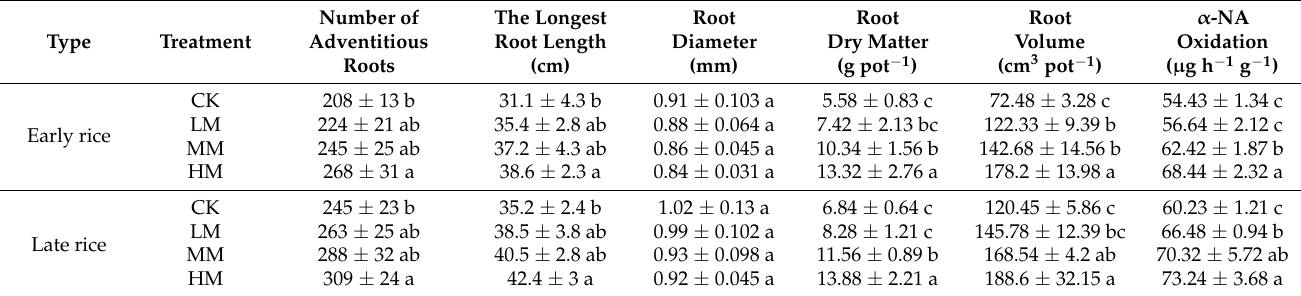
Table 2. Root characteristics of the double cropping rice of different MNB concentrations at the heading stage.